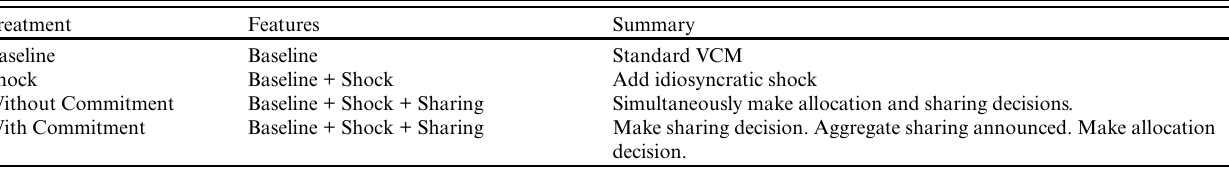
Table 1 . Experimental